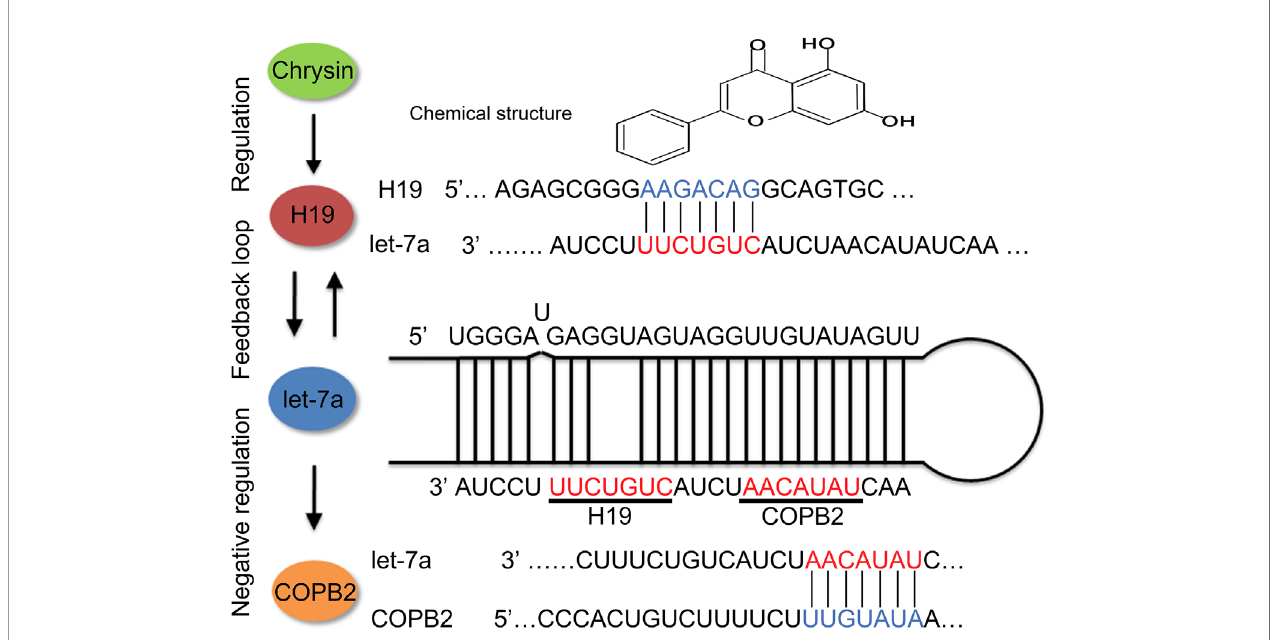
FIGURE 7 | Schematic diagram of H19 /let-7a regulate COPB2 expression.